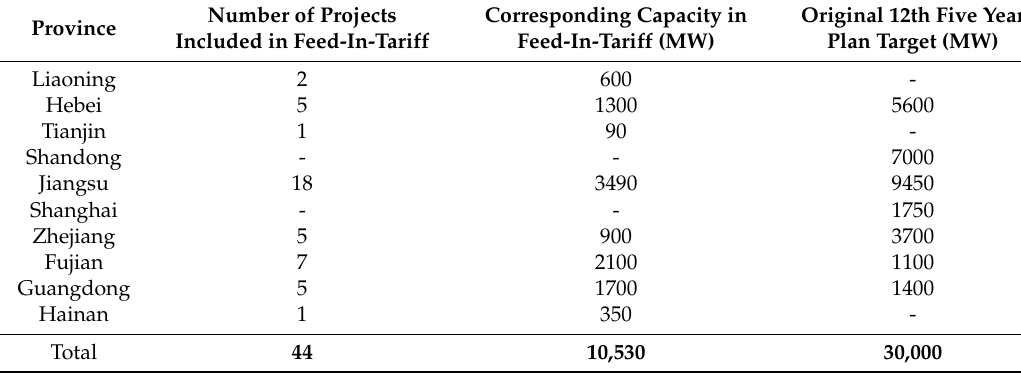
Table 7. “ National offshore wind power development and construction program (2014–2016) ” compared to original 12th Five Year Plan offshore wind targets, by province (Own construction based on [125]). Number of Projects Corresponding Capacity in Original 12th Five Province Included in Feed-In-Tariff Feed-In-Tariff (MW)